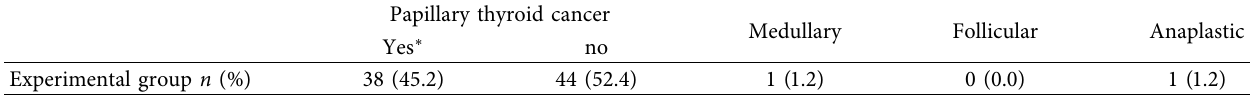
Table 5: Pathological types of b-side thyroid cancer in the experimental